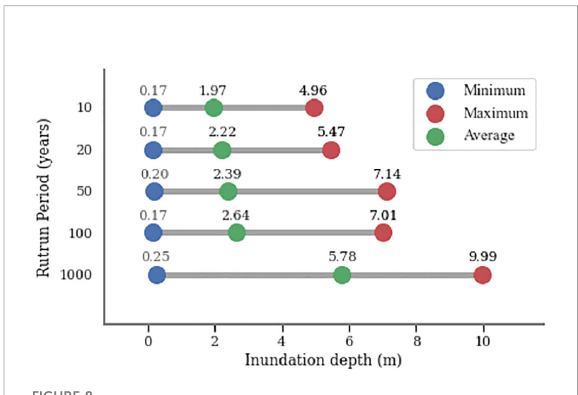
FIGURE 8 The maximum and minimum inundation depth for different de fi ned typhoon